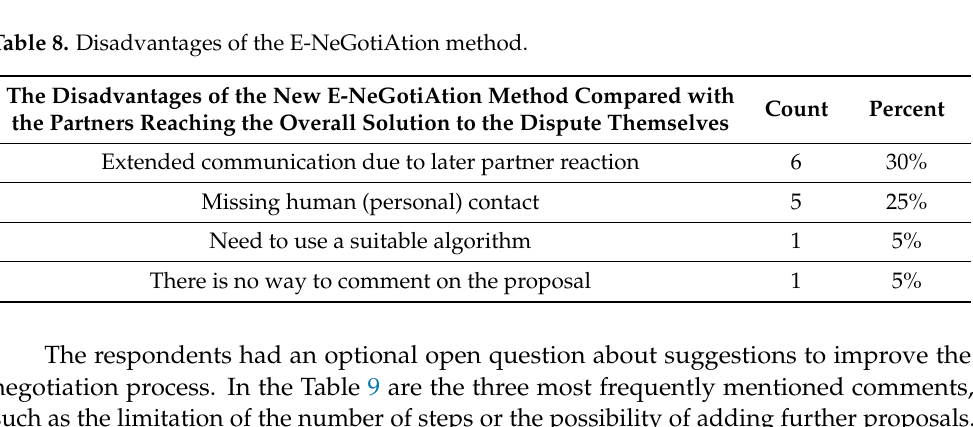
Table 8. Disadvantages of the E-NeGotiAtion method.